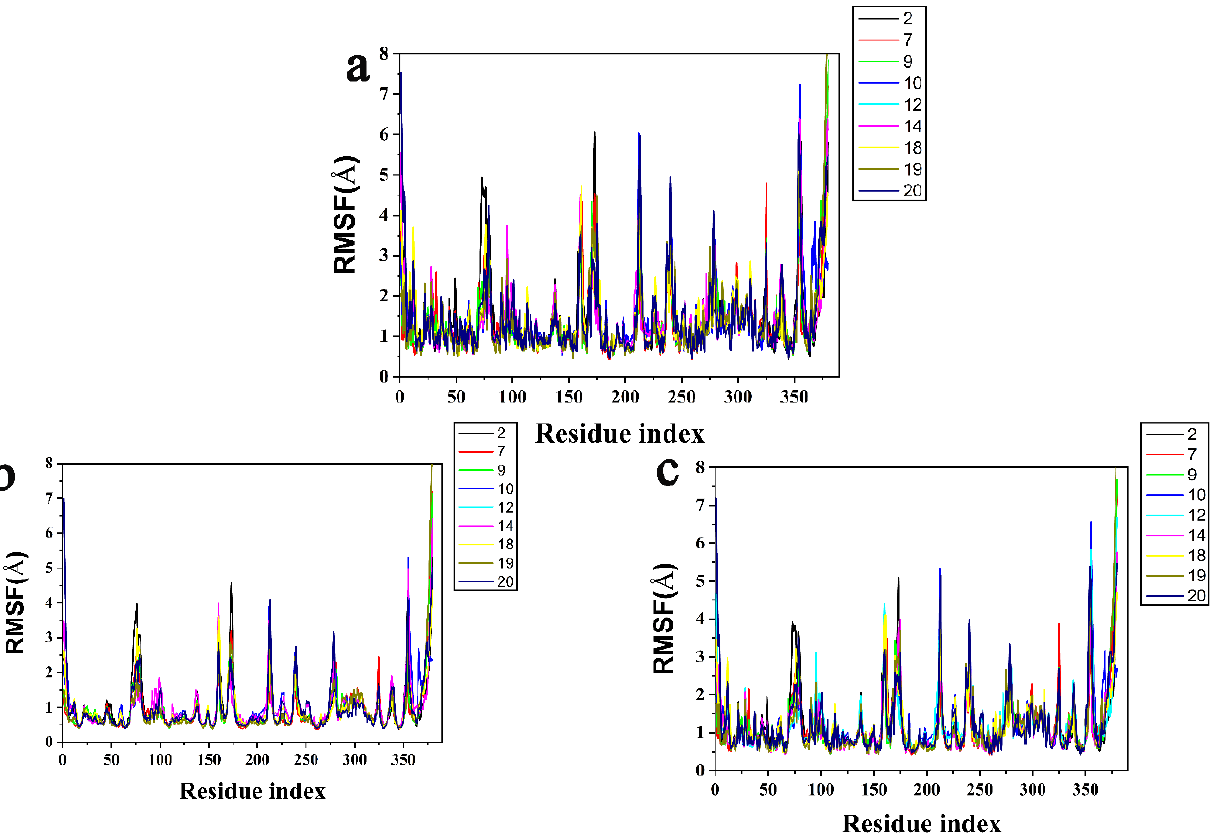
Figure 9. Protein RMSF for ( a ) the protein active pocket with residues of 5 Å around ( b ) Cα atoms and ( c ) heavy atoms.